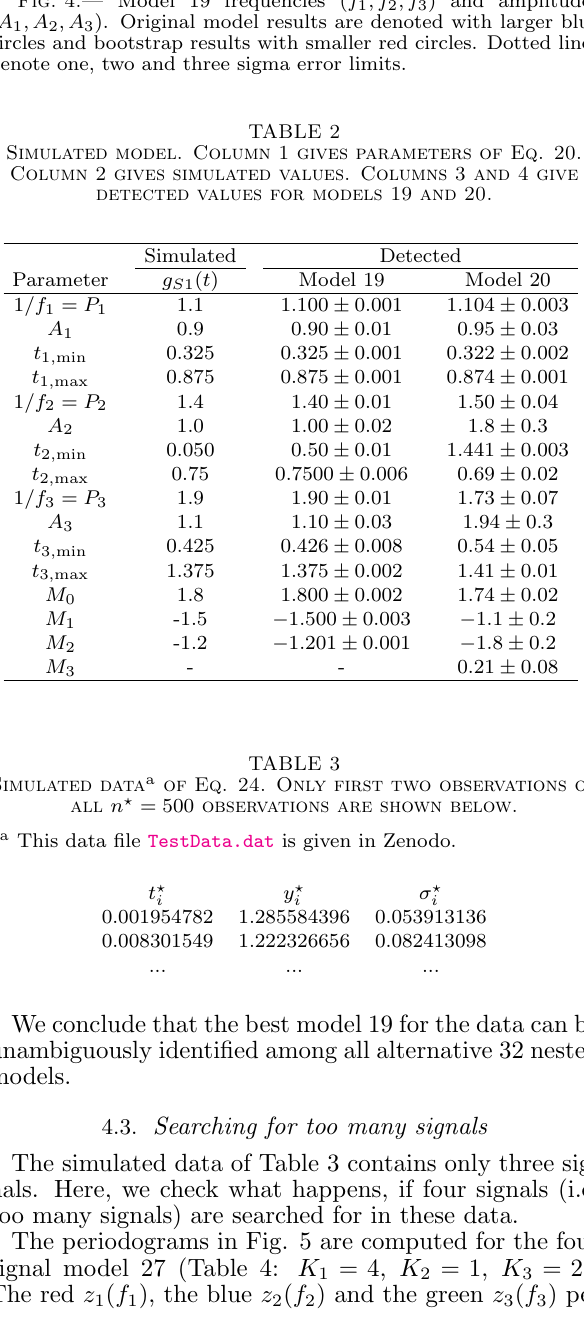
signal model 27 (Table 4: K 1 = 4, K 2 = 1, K 3 = 2). The red z 1 ( f 1 ), the blue z 2 ( f 2 ) and the green z 3 ( f 3 ) pe-